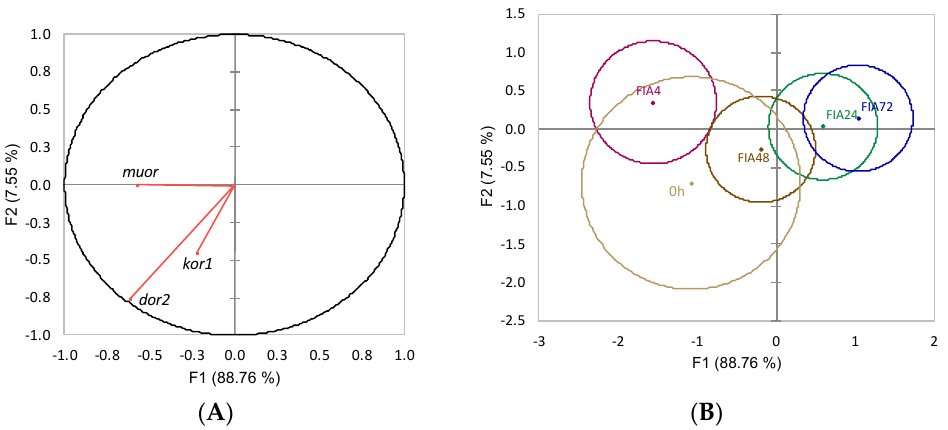
Figure 15. Canonical discriminant analysis of European seabass pituitary gland expression of opioid receptor genes. ( A ) Correlation variables/factors (factor loads) for two main discriminant functions (F1 and F2); muor , mu opioid receptor; kor1 , kappa opioid receptor 1; dor2 , delta opioid receptor 2. ( B ) Canonical discriminant scores of each group. Groups centroid are marked by a small diamond, whereas circles indicate data distribution per group.